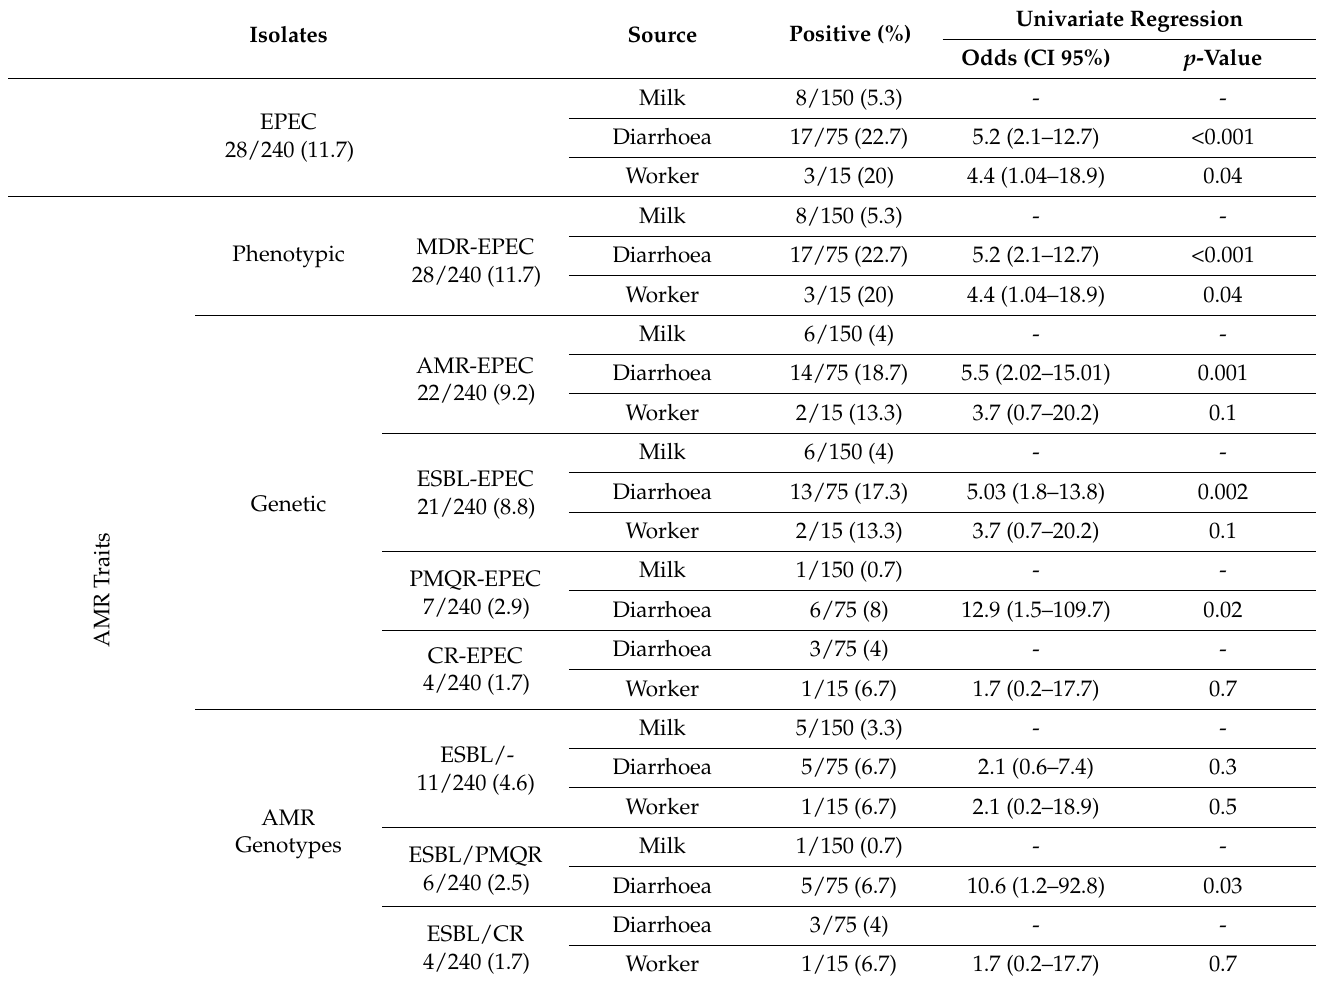
Table 1. Frequency distribution of EPEC and associated AMR traits in samples collected from different sources in dairy farms.